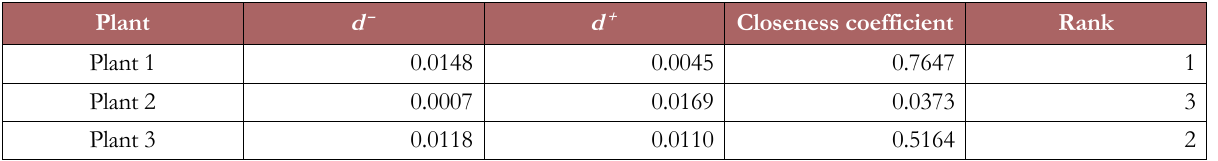
Table 16. Distance, closeness coefficient and the rank of each plant (universal integration)